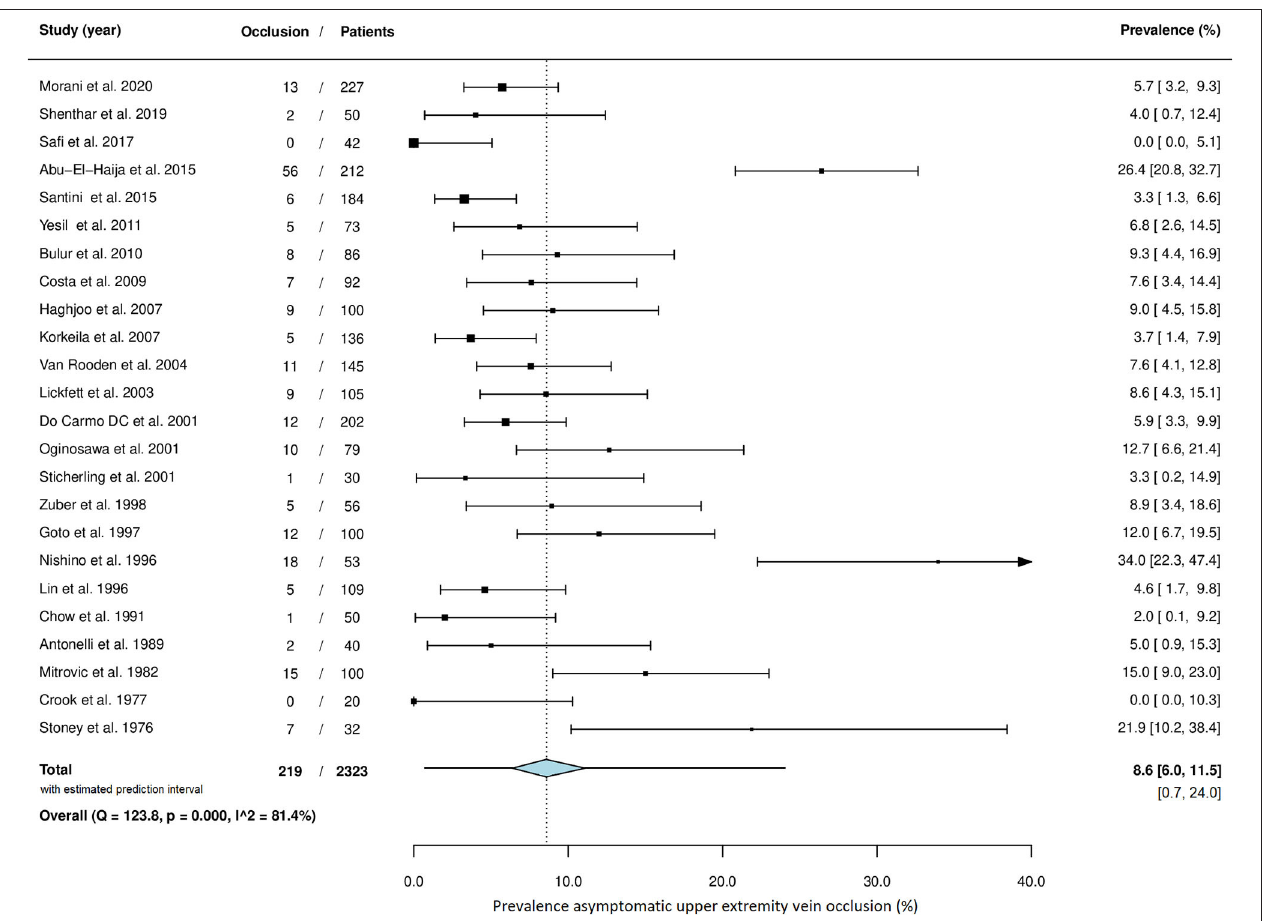
FIGURE 4 | Meta-analysis of the prevalence of asymptomatic upper extremity vein